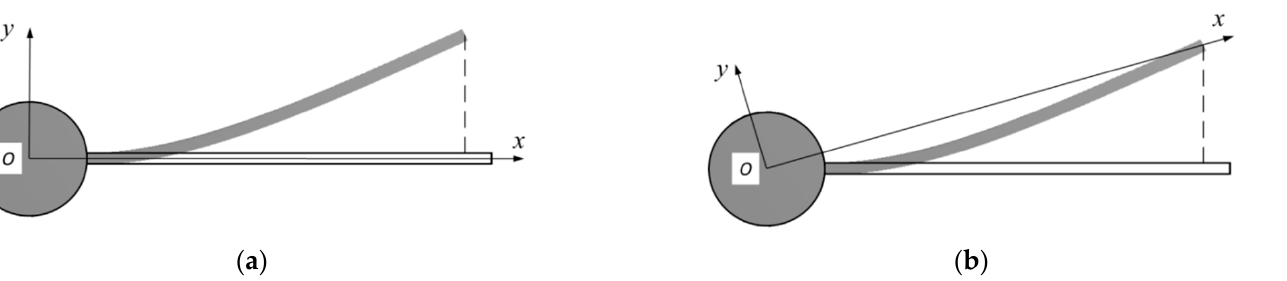
Figure 3. Illustration of two coordinate systems: ( a ) tangential Coordinate System; ( b ) virtual Link Coordinate System.